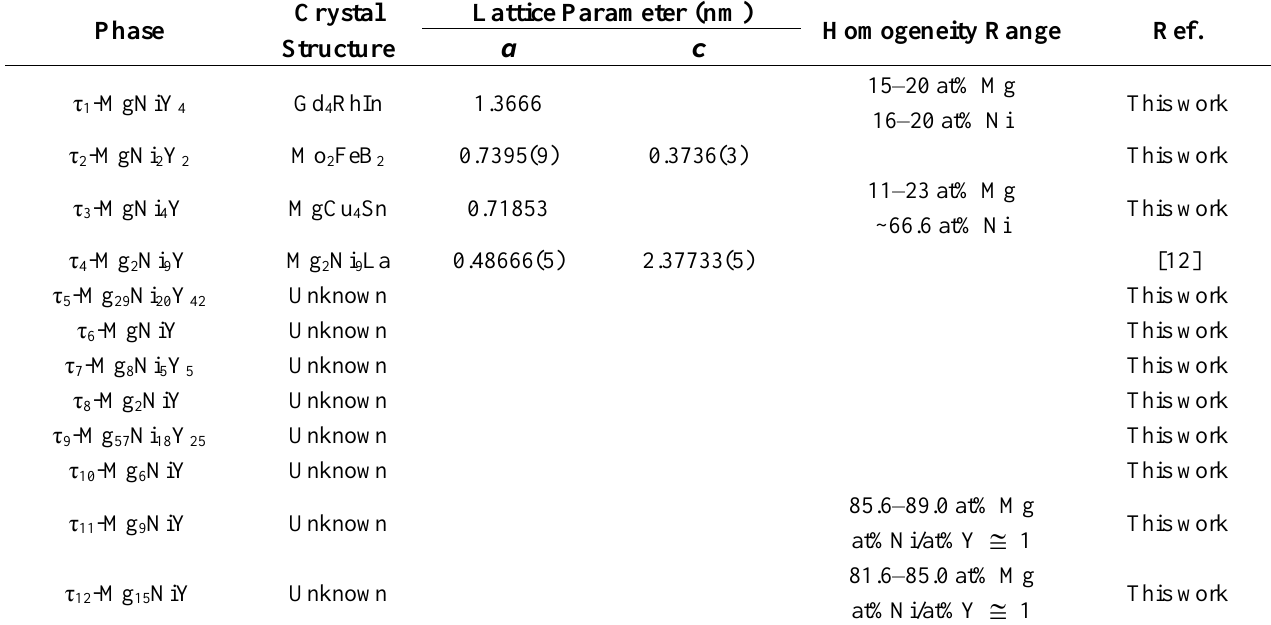
Table 1. Ternary intermetallic compounds in the Mg-Ni-Y system.